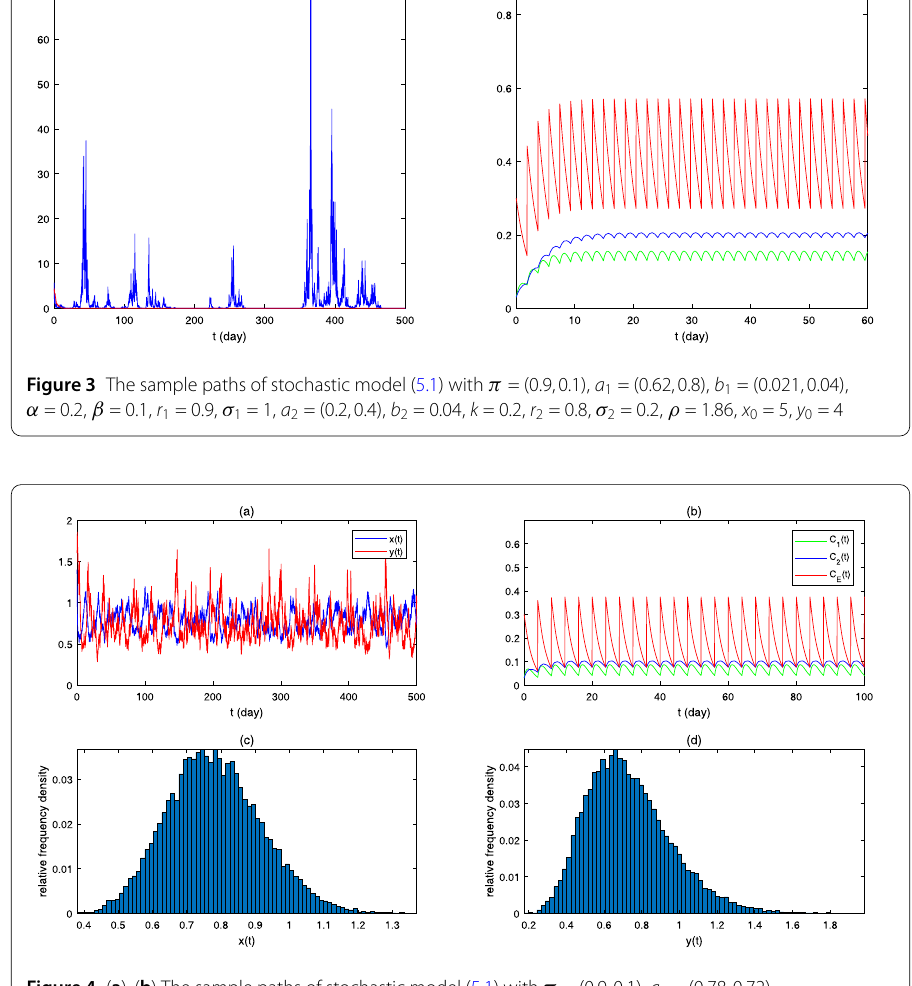
Figure 4 ( a ), ( b ) The sample paths of stochastic model (5.1) with π = (0.9,0.1), a 1 = (0.78,0.72), b 1 = (0.52,0.48), α = 0.98, β = 0.84, r 1 = 0.1, σ 1 = 0.1, a 2 = (0.24,0.18), b 2 = 0.1, k = 0.86, r 2 = 0.1, σ 2 = 0.2, ρ = 4, x 0 = 1.4, y 0 = 1.6; ( c ), ( d ) The density function diagrams of x ( t ) and y ( t ),